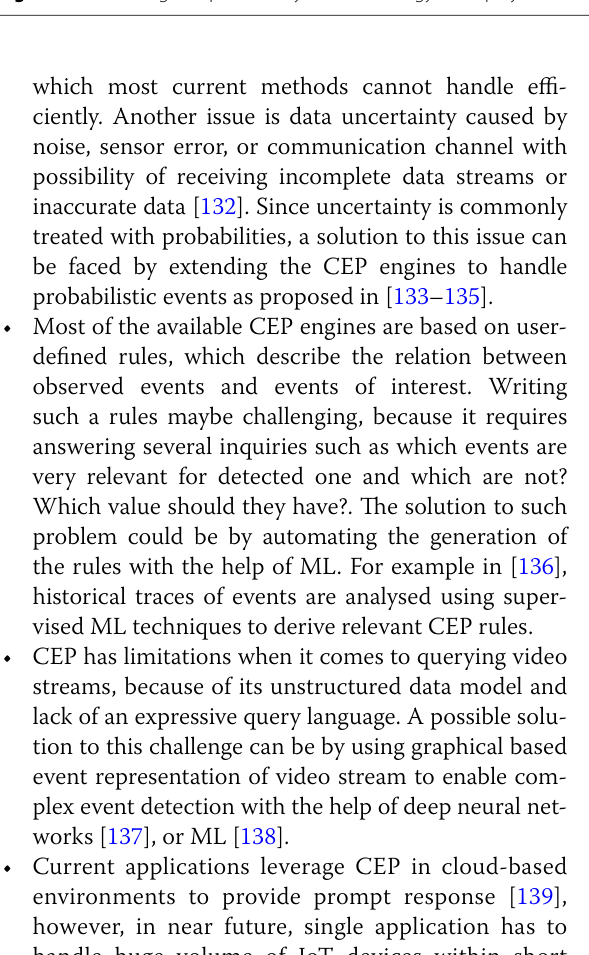
Fig. 11 The challenges experience by CEP technology for deployment of massive IoT devices with suggested